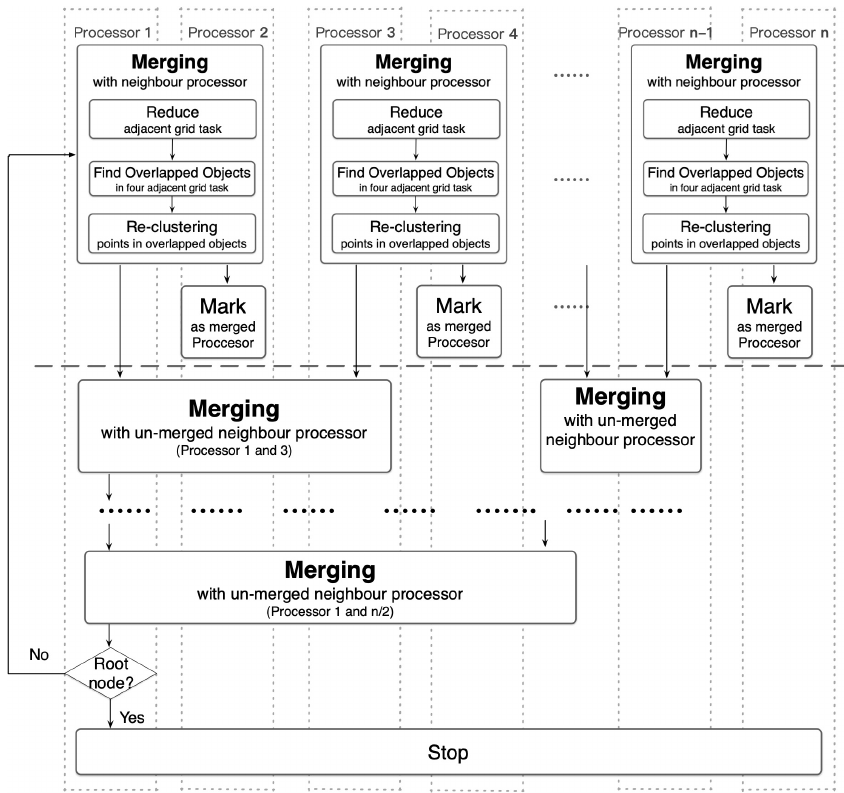
Figure 8. Identifying heat objects through a geocode-aware